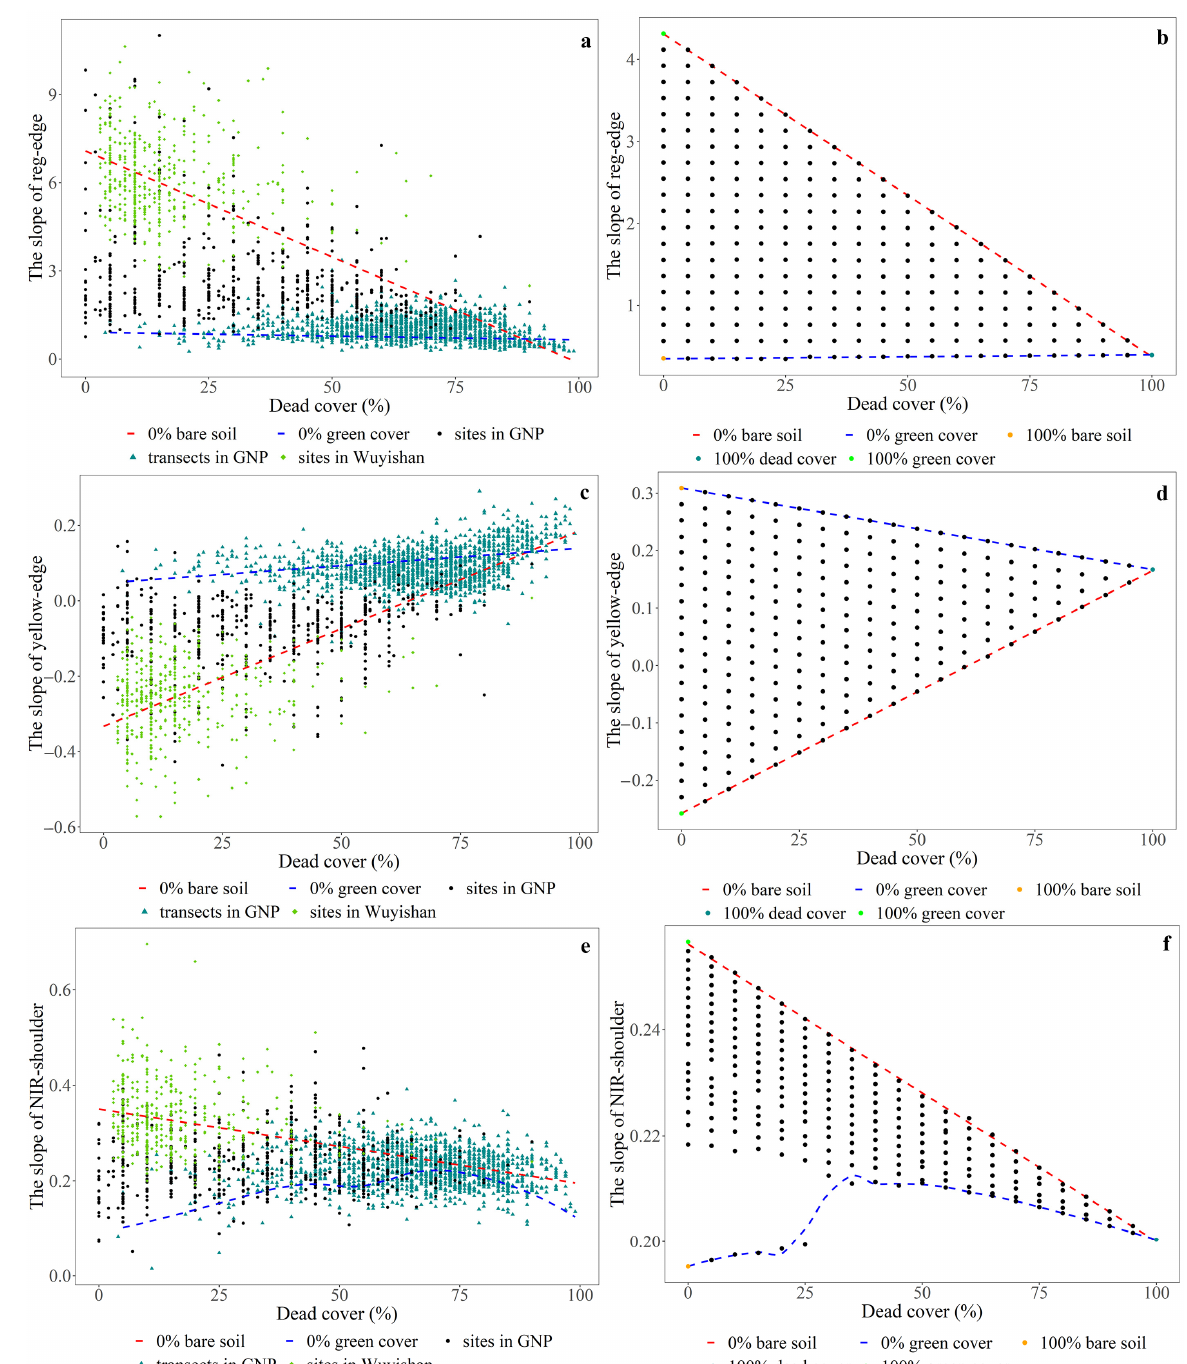
Figure 3. Relationships between the slope of red-edge, yellow-edge, NIR shoulder and dead cover (“sites in GNP”, “transects in GNP” and “sites in Wuyishan” refer to the quadrat data collected in the sample sites in Grassland national park (GNP), in the transects in GNP, and in the sample sites in Wuyishan National Park (WNP), respectively; the red dash line refer to the linear relationship in the situation when the coverage of bare soil equals to 0%; the blue dash line means the relationship in the situation when green cover equals to 0%). The relationship between the slope of red-edge ( a ), yellow-edge ( c ), NIR shoulder ( e ) from in situ measured hyper-spectra and dead cover; the relationship between the slope of red-edge ( b ), yellow-edge ( d ), NIR shoulder ( f ) from simulated hyper-spectra and dead